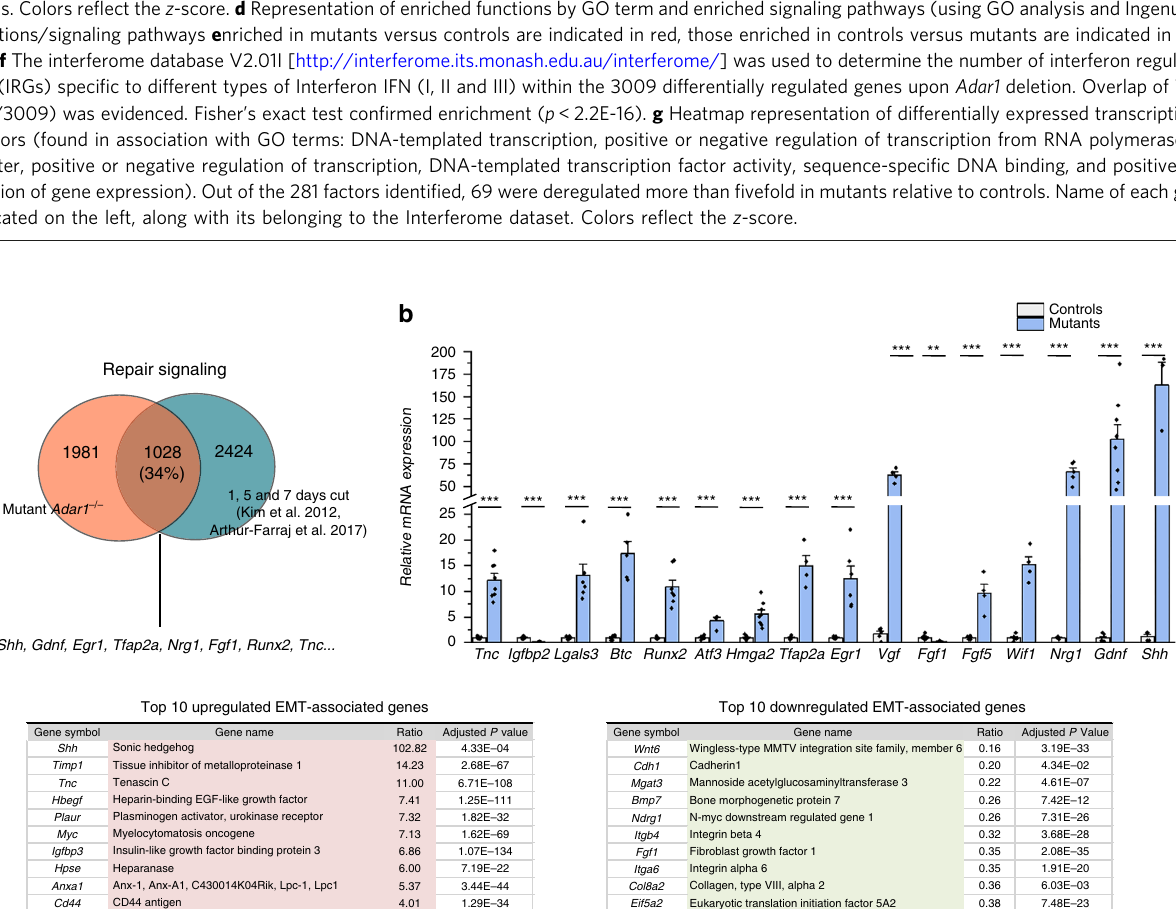
Fig. 6 Activation of an injury-associated gene expression program in mutants. a Venn diagram showing signi fi cant overlap between RNA-seq data generated in this study (orange) and differentially expressed genes upon peripheral nerve injury (blue) 39,40 . The number of genes in each category, the % of overlap and representative genes are indicated. Fisher ’ s exact test con fi rmed enrichment ( p < 2.2E-16). Note that 1028 out of 3009 genes we found deregulated are overlapping with published datasets. b Validation of a subset of differentially expressed genes by RT-qPCR. All data represent mean ± SEM. Statistical differences between the groups ( n = 4 – 6 controls and n = 4 – 8 mutants depending on tested genes) were determined using t test (asterisks represent p values: * p < 0.05, ** p < 0.01, *** p < 0.001). Source data are provided as a source data fi le. c Of the 111 EMT-associated genes found to be differentially expressed between uncut and cut nerves 39 , 34% were also deregulated upon Adar1 deletion. Top 10 up-(pink) and down-(green) regulated genes found in common, ( p -adj < 0.05) are indicated. Note that “ EMT-associated genes ” are more generally associated to migration and cell adhesion